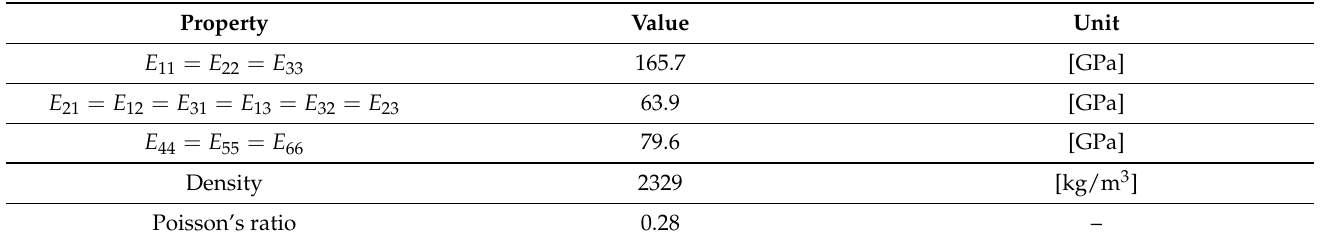
Table 2. Material properties considered in the FEA simulations.